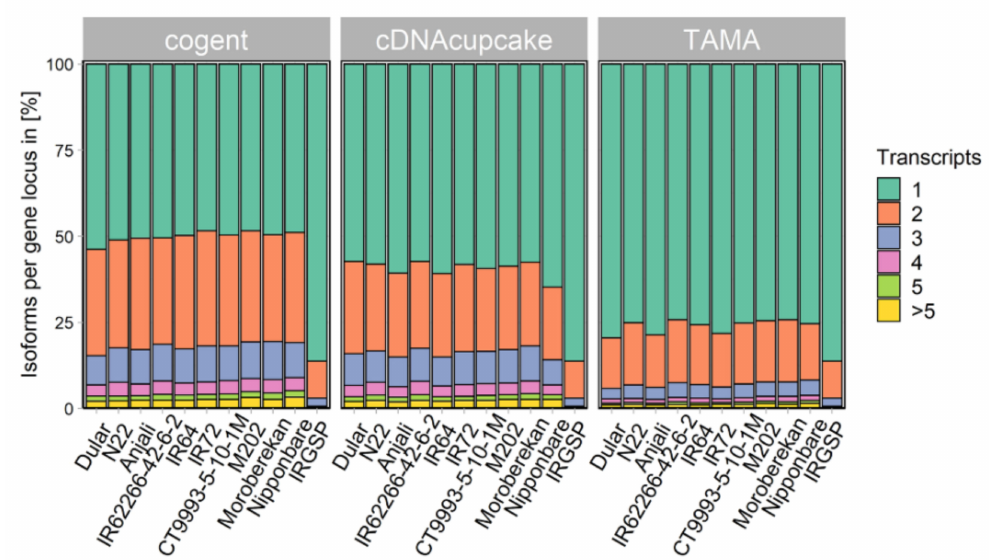
Figure 2. Fraction of isoforms per gene locus for the ten Oryza sativa L. ( Poaceae ) cultivars and the Nipponbare reference transcriptome (IRGSP). Cultivars were sorted alphabetically within the subspecies aus , indica and japonica .